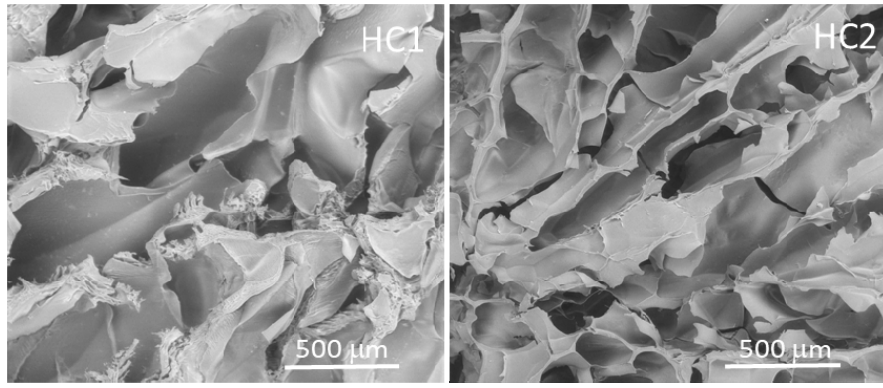
Figure 1. Scanning electron microscope images of chitosan-based HC1 and HC2 hydrogels.